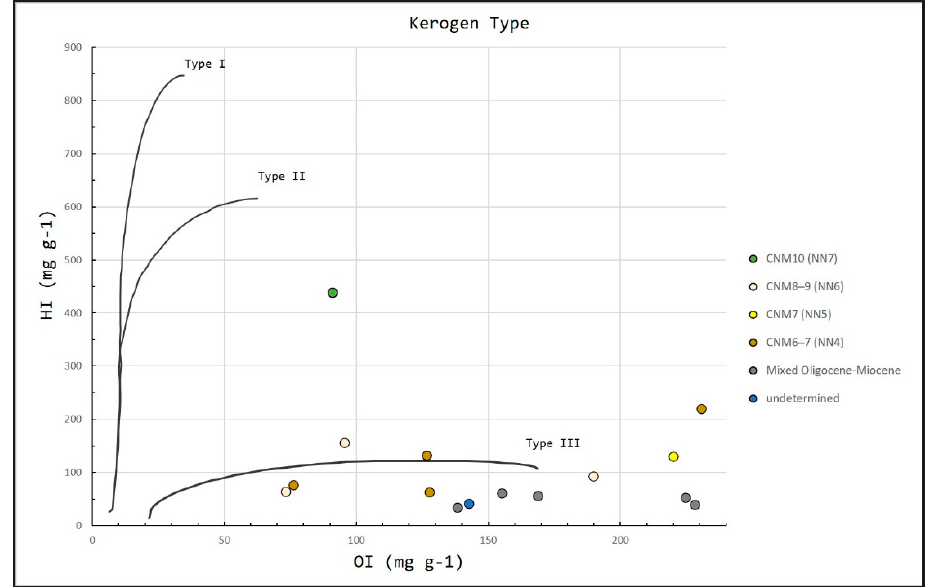
Figure 7. Modified van Krevelen diagram presenting the results of the Rock-Eval pyrolysis. One mudstone clast (LEV1GC 4–6 clast 1) dated as middle Miocene (CNM10 biozone) demonstrates different geochemical characteristics from the rest of the samples.